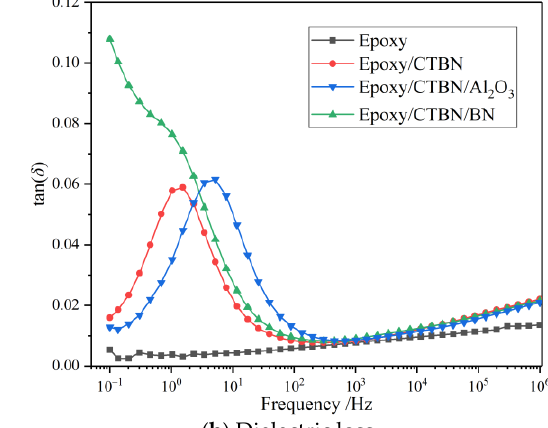
Figure 6. Peak-splitting results of the HN-equation of three kinds of samples at 25 ℃ . ( a ) Epoxy/CTBN; ( b ) Epoxy/CTBN/Al 2 O 3 ; ( c ) Epoxy/CTBN/BN. Table 2. Relaxation parameters fitted by the HN-equation of three kinds of samples at 25 ℃ .